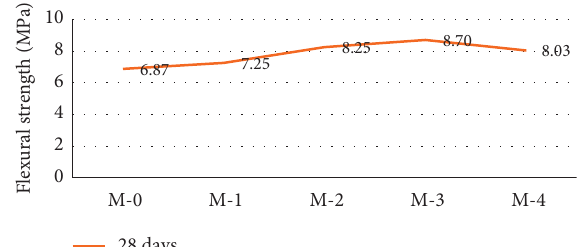
Figure 3: Flexural strength test result.